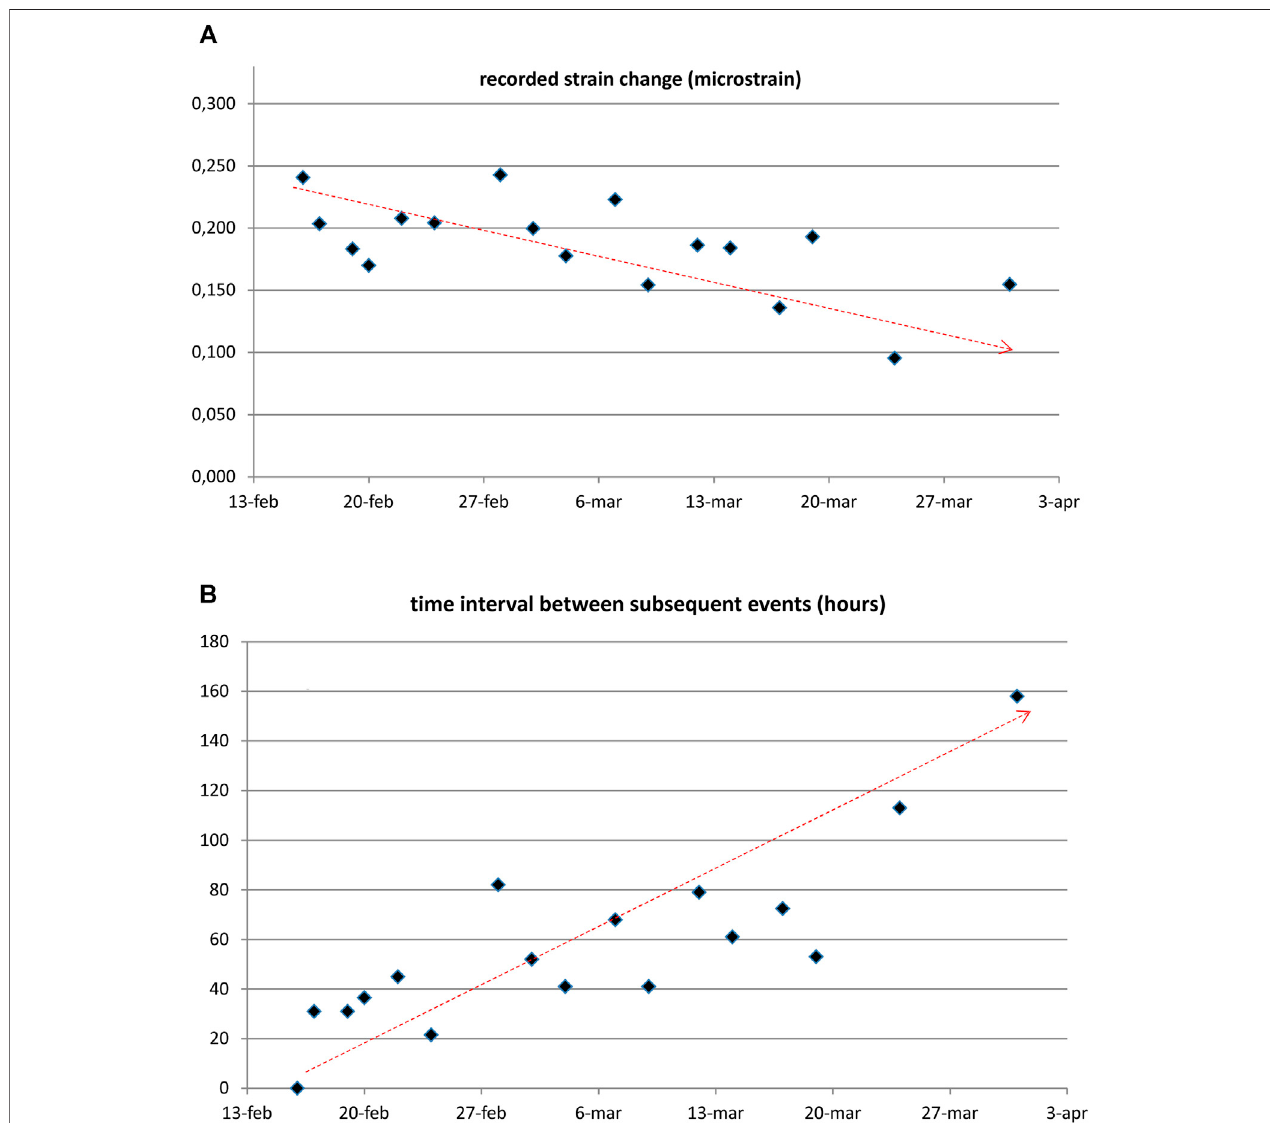
FIGURE 4 | (A) strain change amplitudes recorded during the lava fountain events. The changes showed a decrease in amplitudes over time. ( B ) the time interval between two consecutive lava fountains lengthened over time.